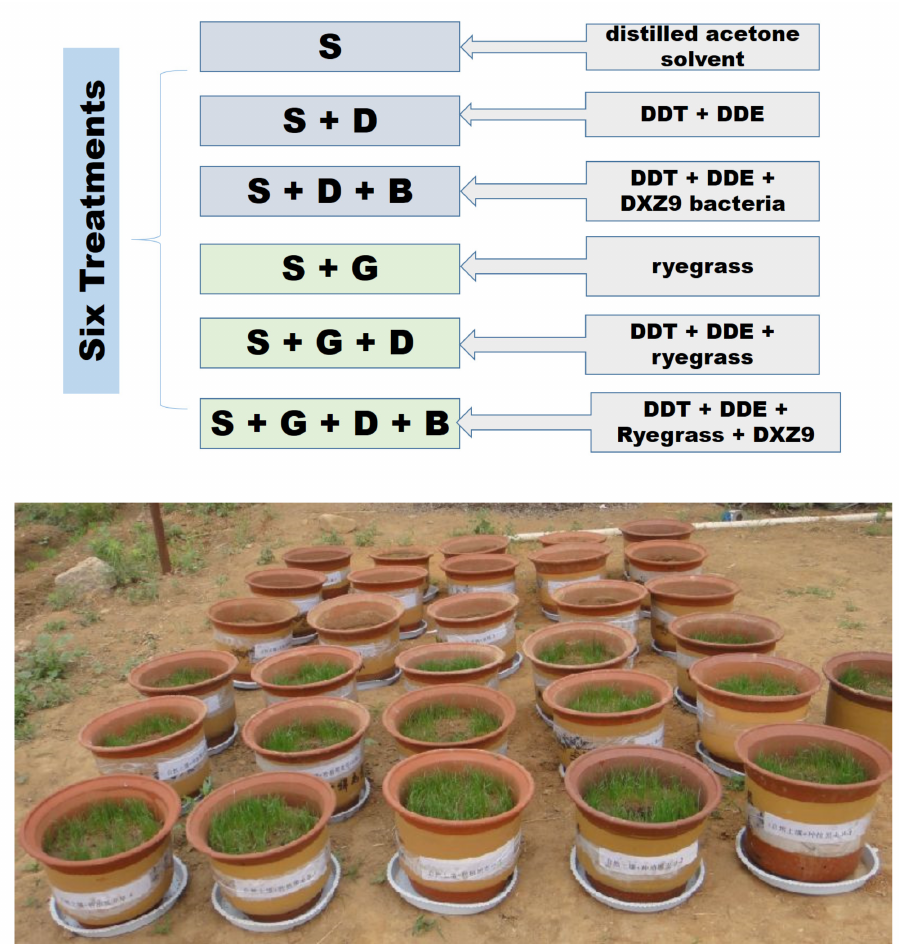
Figure 1. Experimental design and photos of the experiment on day